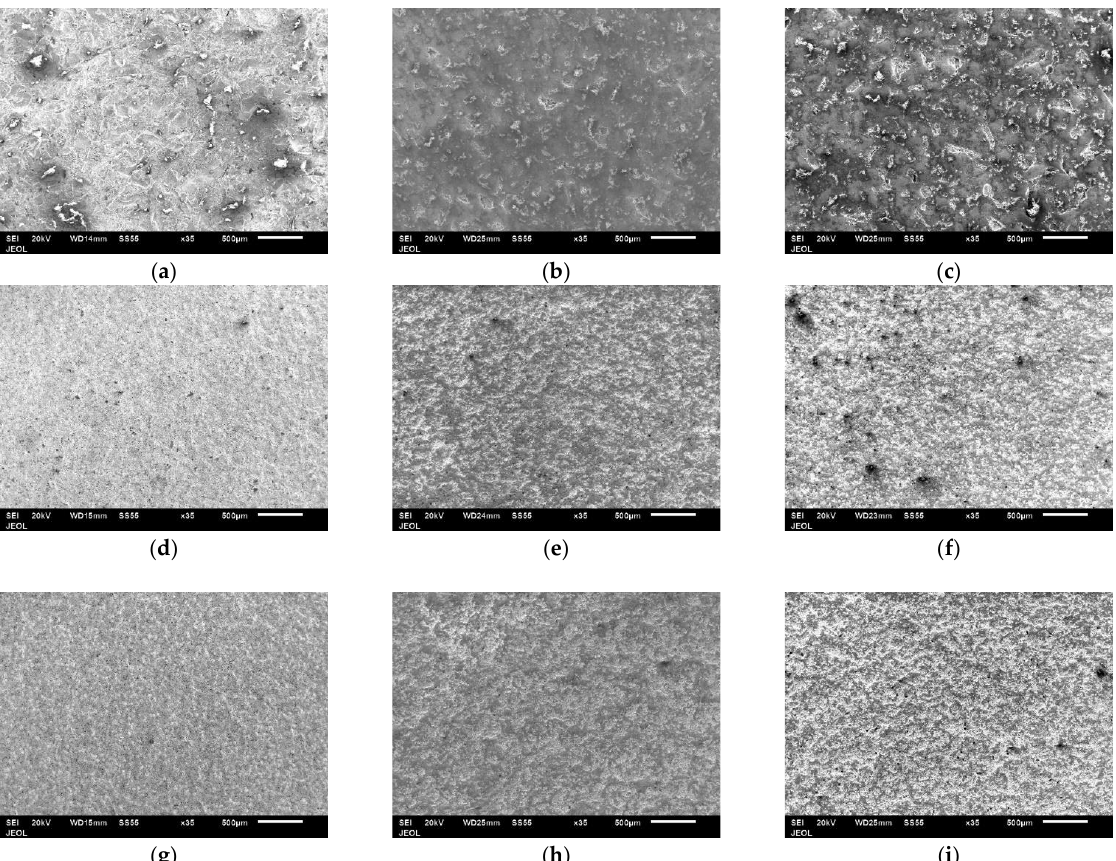
Figure 17. Low magnification SEM images showing surface morphologies of; substrate ( a – c ); WC- 12Co coating; ( d – f ) and WC-10Co-4Cr coating; ( g – i ). Note: ( a ) after shot blasting (blank), after erosion test for: ( b ) 2 h and ( c ) 3 h; ( d ) As-sprayed, after erosion test for: ( e ) 2 h and ( f ) 3 h; ( g ) As-sprayed, after erosion test for: ( h ) 2 h and ( i ) 3 h.